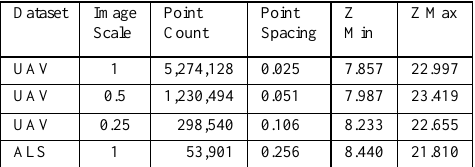
Table 1. Showing Point Cloud